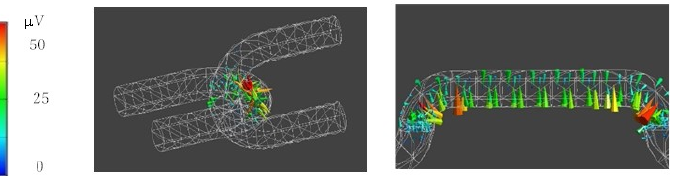
Figure 6. Piezoelectric response of an entangled piezoelectric braided cord under tensile stress.